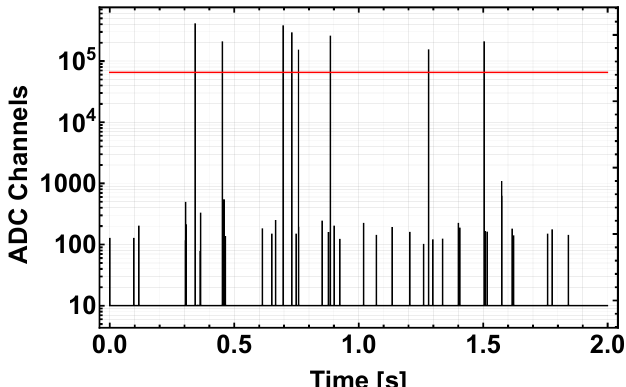
Figure 16. The expected response of a detection channel for the first 2 s of mission. The horizontal red line represents the ADC limit: each peak that crosses such limit corresponds to a saturated event (mostly protons).